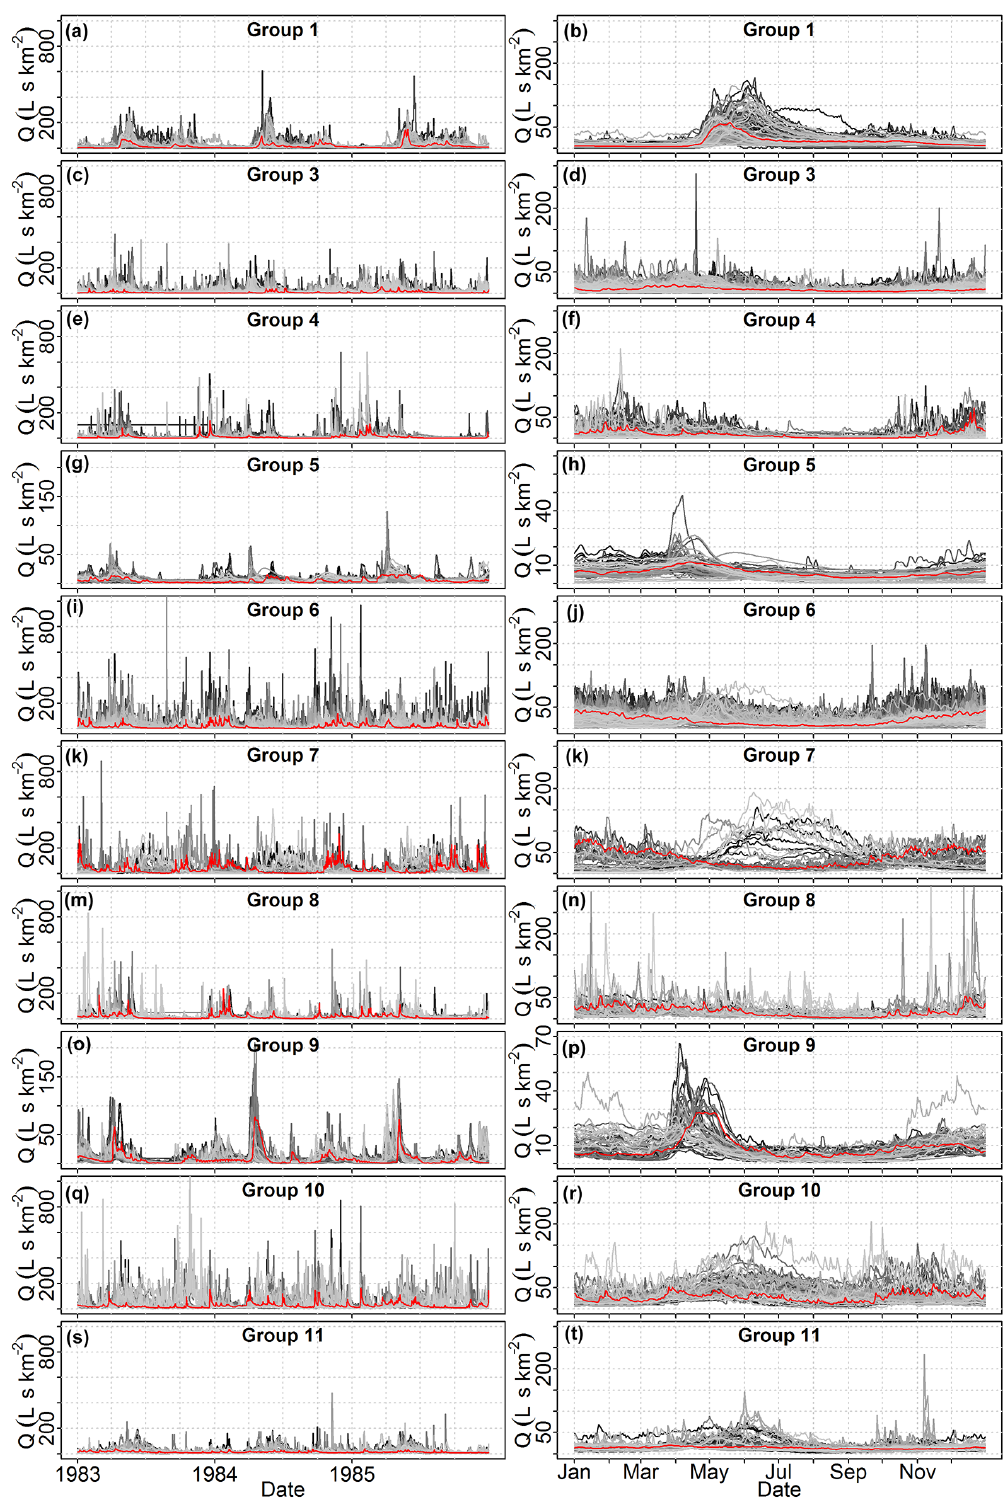
Figure 7. Three-year hydrographs (left) and average annual hydrographs based on >5-year daily flows (right) at the stream gauges of the CART classification classes. Grey → black: all stream gauges belonging to the class; red: stream gauge where the flow signatures are closest to the class median flow signatures. Note that the scales are different for classes 5 and 9 and that this classification does not contain any class No. 2 as explained in Sect.